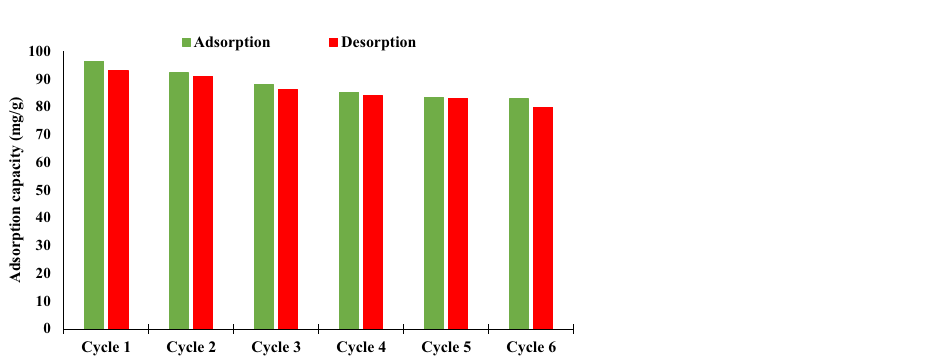
Figure 14. Adsorption capacity of phenol onto MSAC composite in successive cycles (C 0 = 300 mg/L, pH = 7, concentration = 1.5